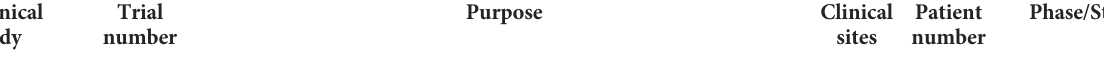
TABLE 4 A summary table on the ongoing clinical trials assessing cilta-cel safety and ef fi cacy in the treatment of MM under various conditions. Clinical